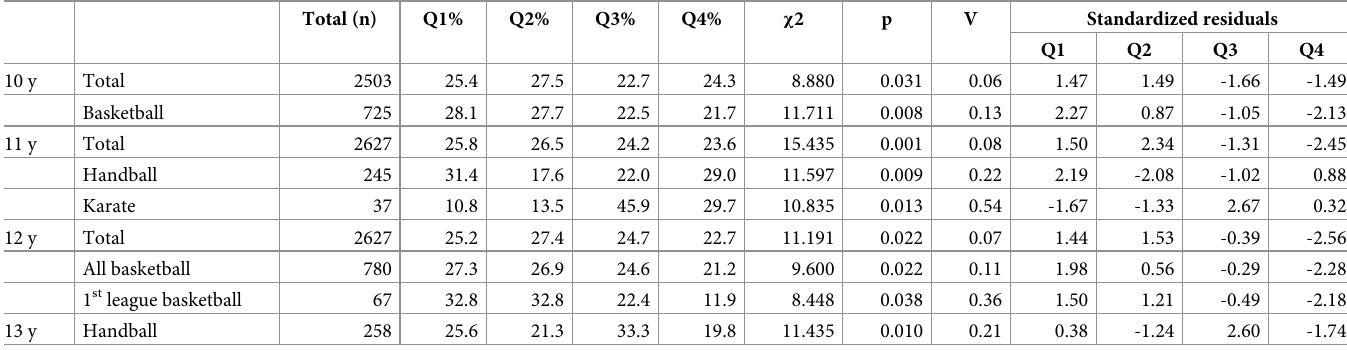
Table 5. Descriptive statistics of the birth distribution of female sport participants divided by age group (only statistically significant results are